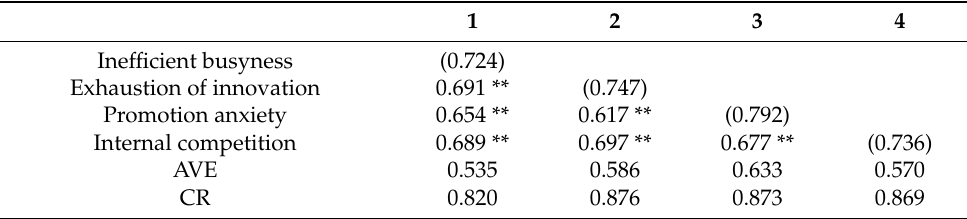
Table 9. The correlation coefficient, CR value, and AVE value of each